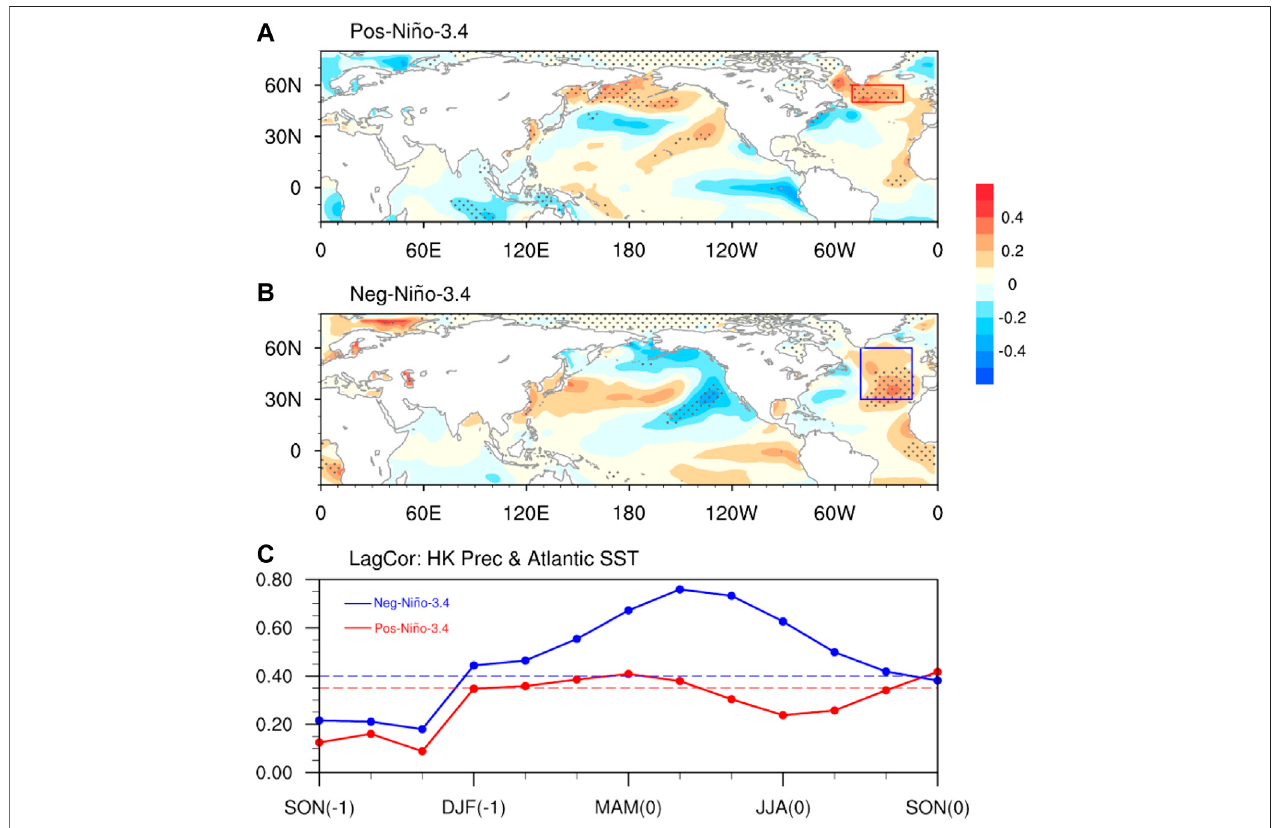
FIGURE 7 | Regression of spring SST (K) onto summer HK Prec for years with (A) a positive Niño-3.4 summer and (B) a negative Niño-3.4 summer. Stippling indicates the 90% con fi dence level. (C) Lead – lag correlation between HK Prec and seasonal mean SST-Atl-P for positive Niño-3.4 summers (red) and seasonal mean SST-Atl for negative Niño-3.4 summers (blue) . Dashed lines indicate the 90% con fi dence level.